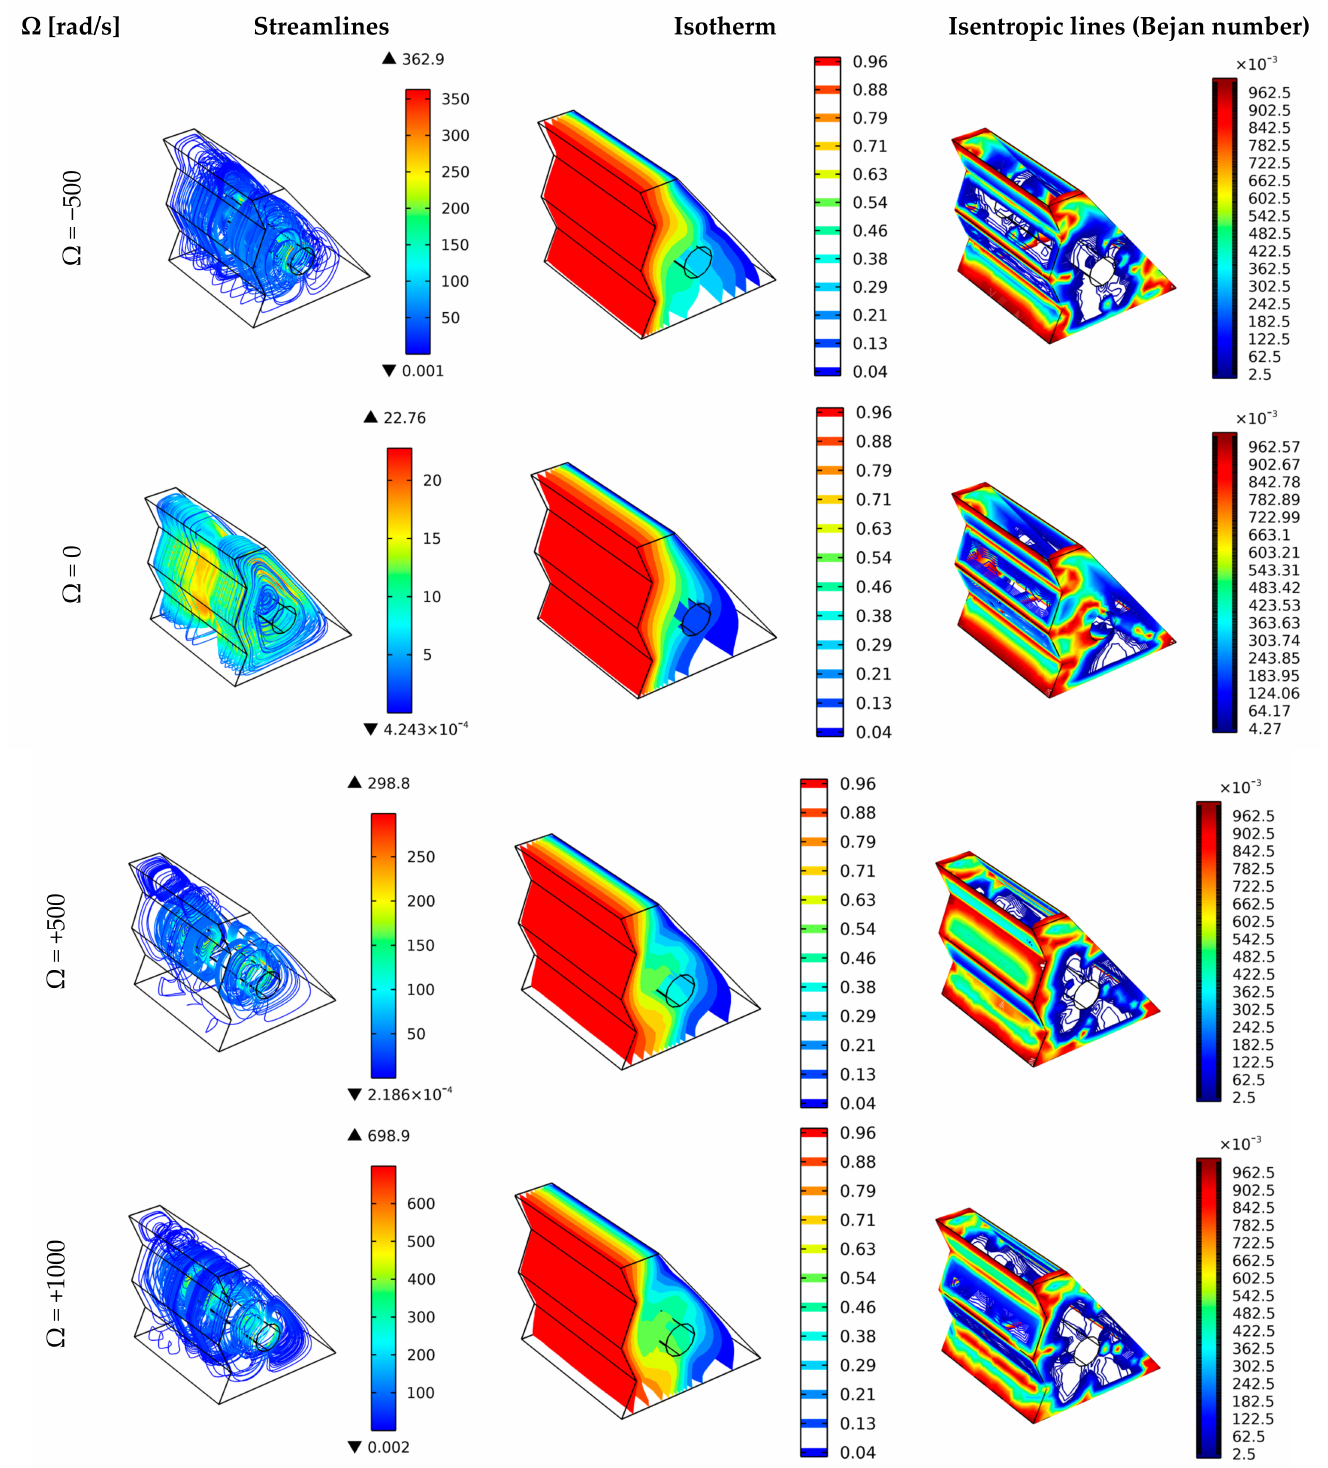
Figure 5. Three-dimensional surface plots to show the effect of the cylinder rotation direction on the streamlines, temperature in terms of dimensionless isotherms, and Bejan